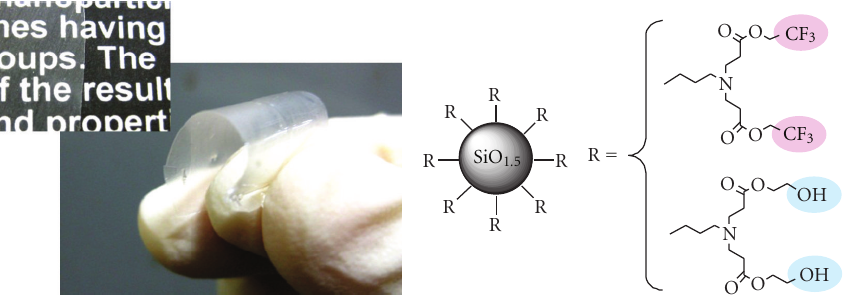
Figure 10: Photograph of flexible film of the TFEA- co -HEA silsesquioxane hybrid prepared by hydrolytic cocondensations. Reprinted with permission from [92]. Copyright 2012